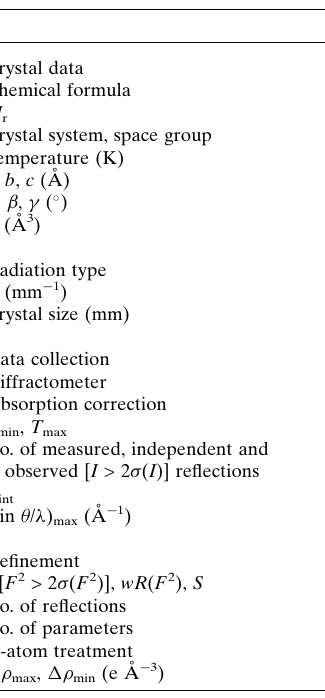
Table 4 Experimental details.